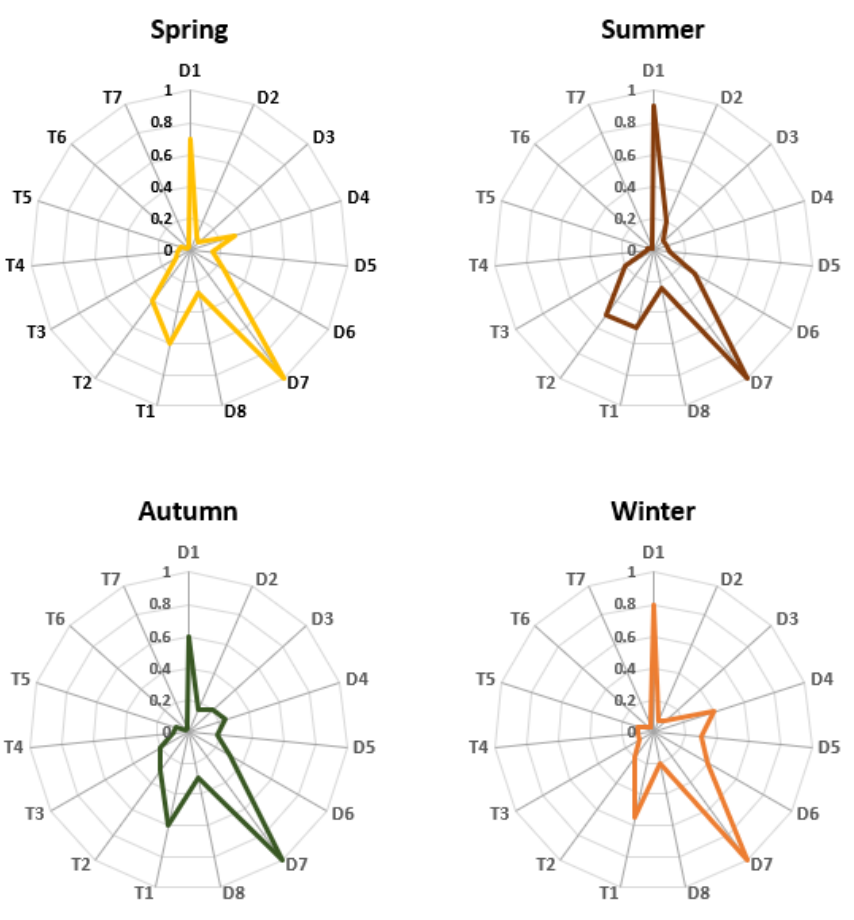
Table 4. The final feature selection result of four datasets. Season